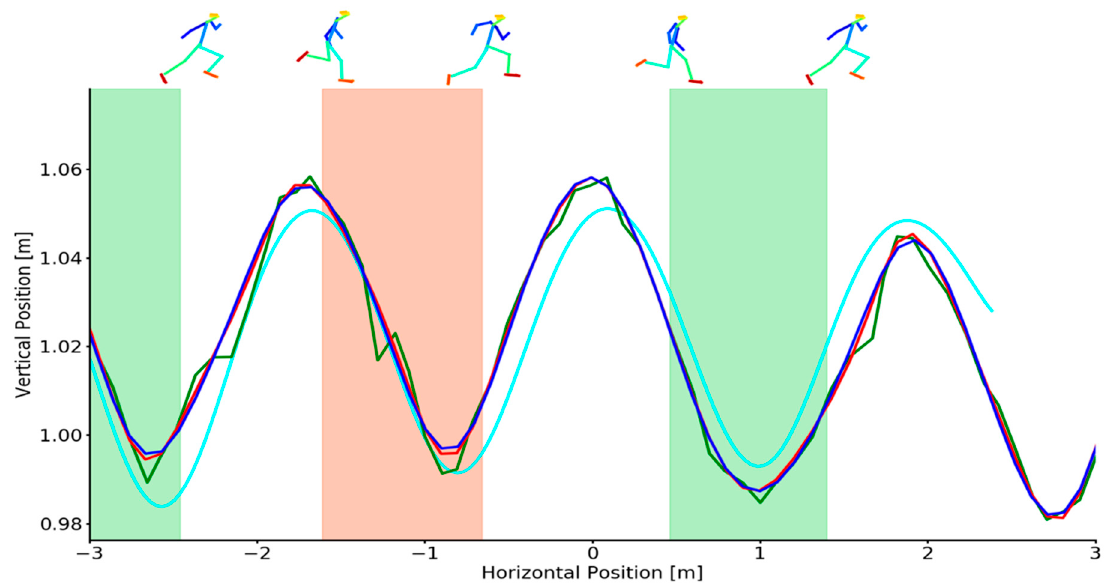
Figure 1. Example individual trial demonstrating sagittal plane CoM positions for criterion (cyan), unfiltered (green), low-pass filtered (red) and Kalman smoothed (blue) data during sprinting. Shaded areas depict the left foot (red shading) and right foot (green shading) stance phase. Footfall events were computed from marker-based foot kinematics [32] . OpenPose joint centre reconstructions (top) at touch-down and toe-off events are overlaid for context.